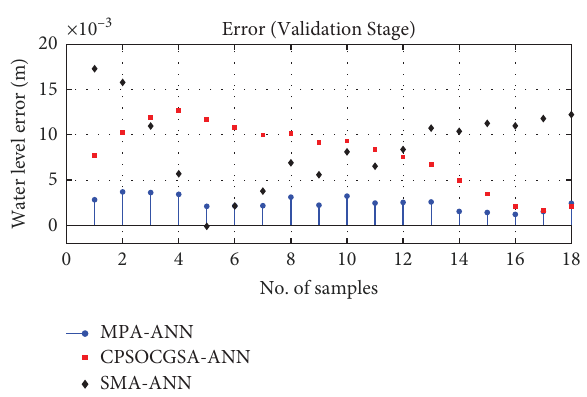
Figure 9: SMA-ANN, MPA-ANN, and CPSOCGSA-ANN error distributions.